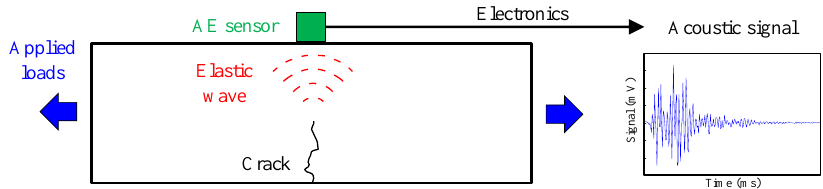
Figure 1. Working principle of an AE monitoring system.